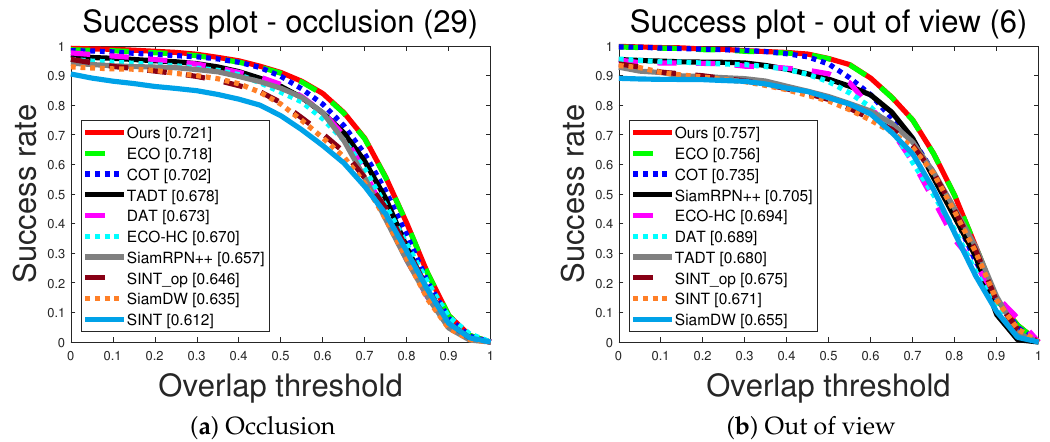
Figure 4. Quantitative comparison in term of the success plot for interrupted and recovered tracking